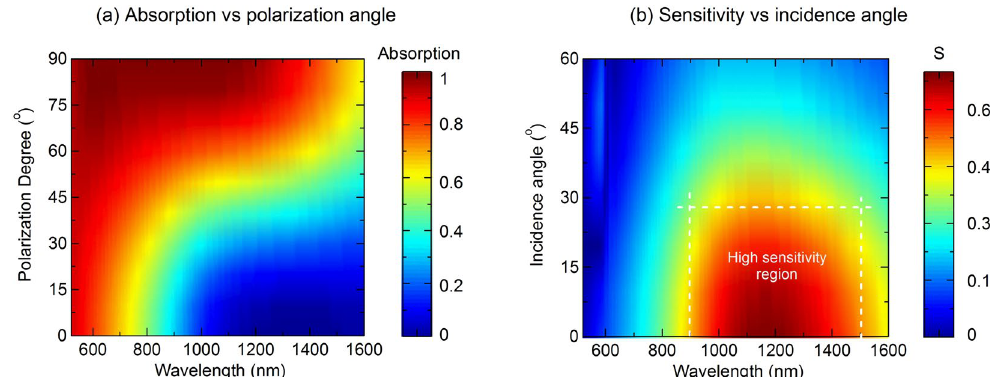
Figure 4. False color plot of absorption spectrum as a function of polarization angle under normal incidence ( a ) and sensitivity as a function of incidence angle ( b ) of the broadband absorber. p-polarization and s-polarization correspond to polarization angles of 90° and 0°